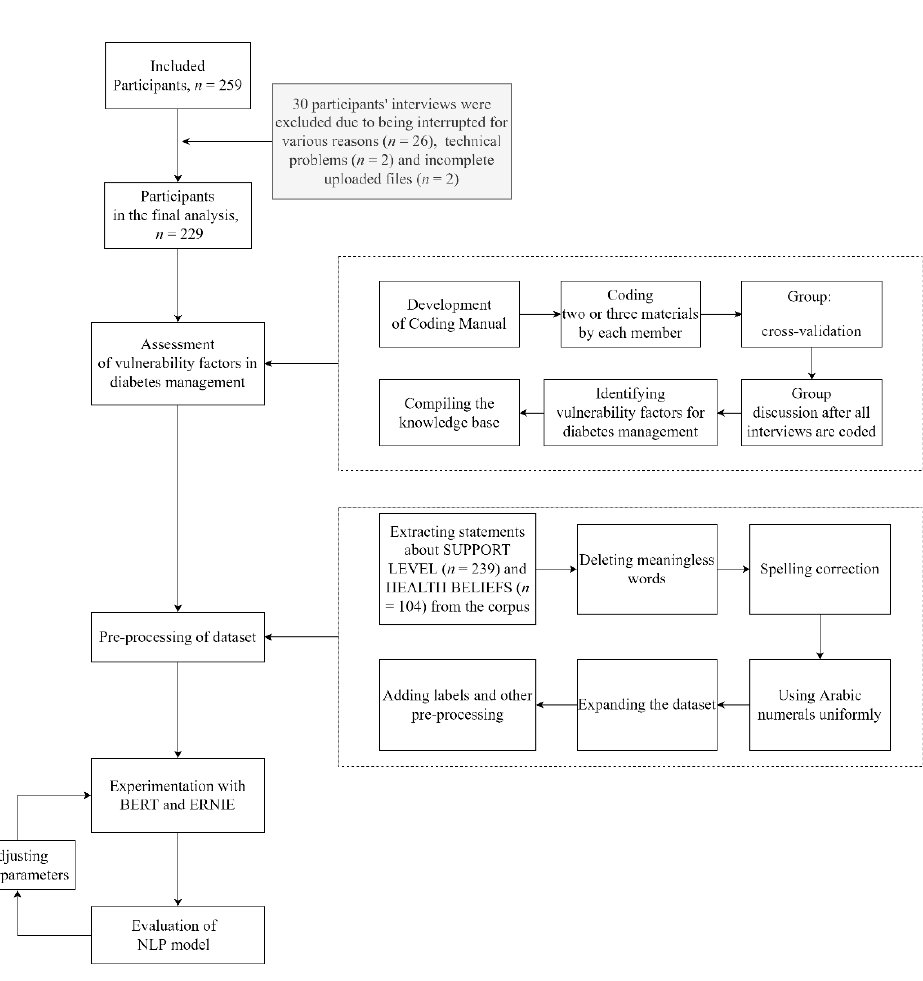
Figure 2. Flowchart of the study.